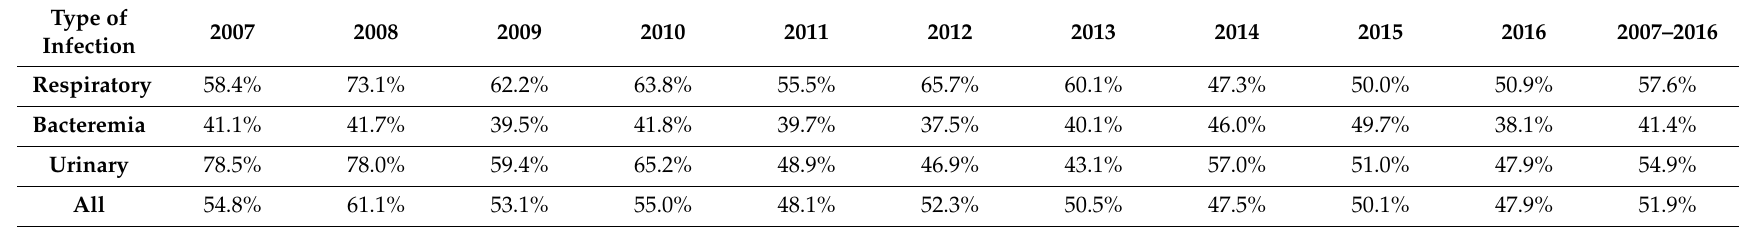
Table 4. Percentage adequacy of the empirical prescription of an antibiotic if based on LRM recommendations with reference to the actual susceptibility of isolated bacteria by year and by type of infection.